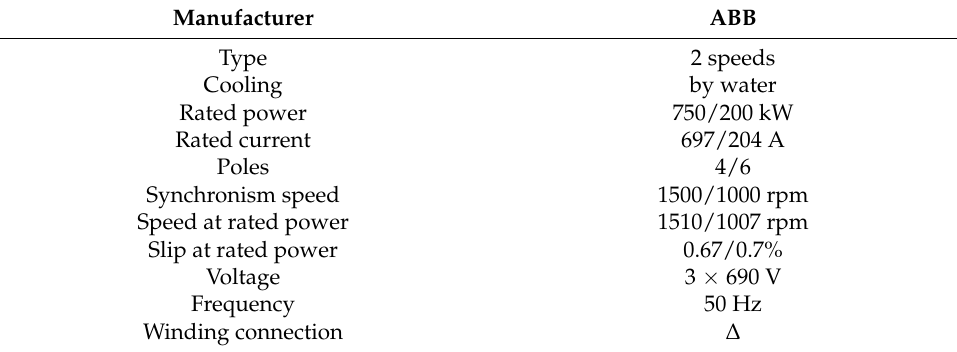
Table 3. Technical characteristics of the